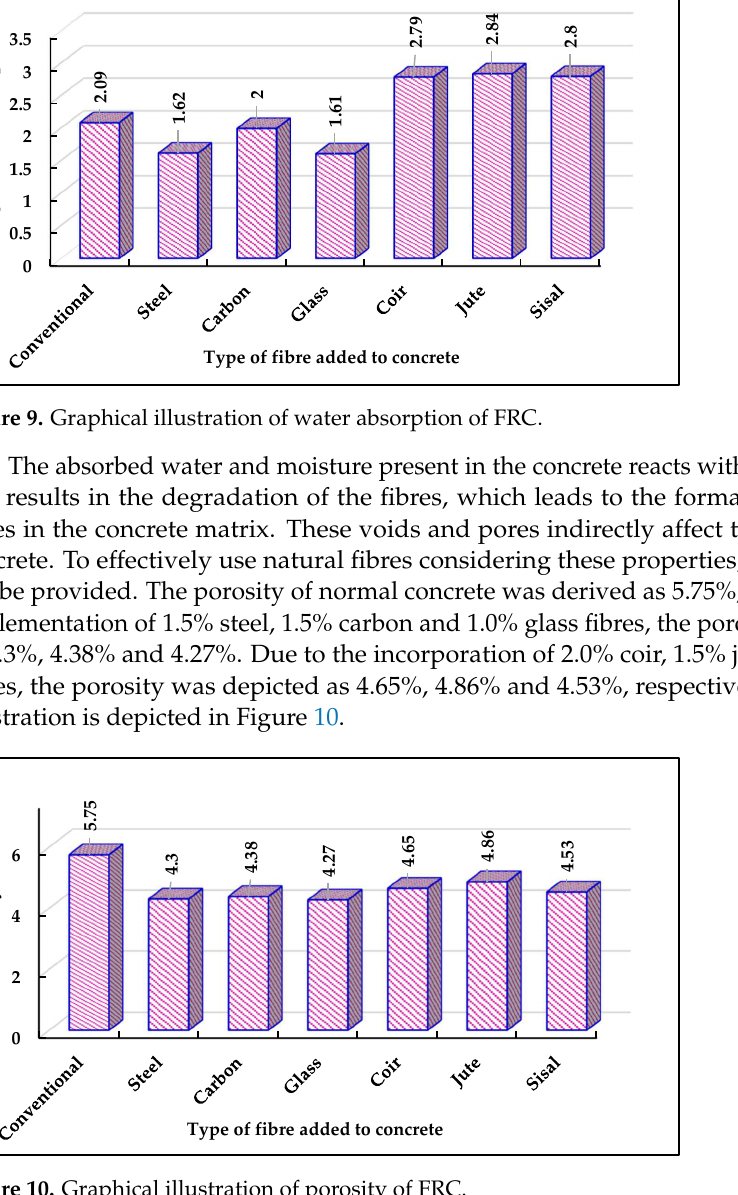
Figure 10. Graphical illustration of porosity of FRC.